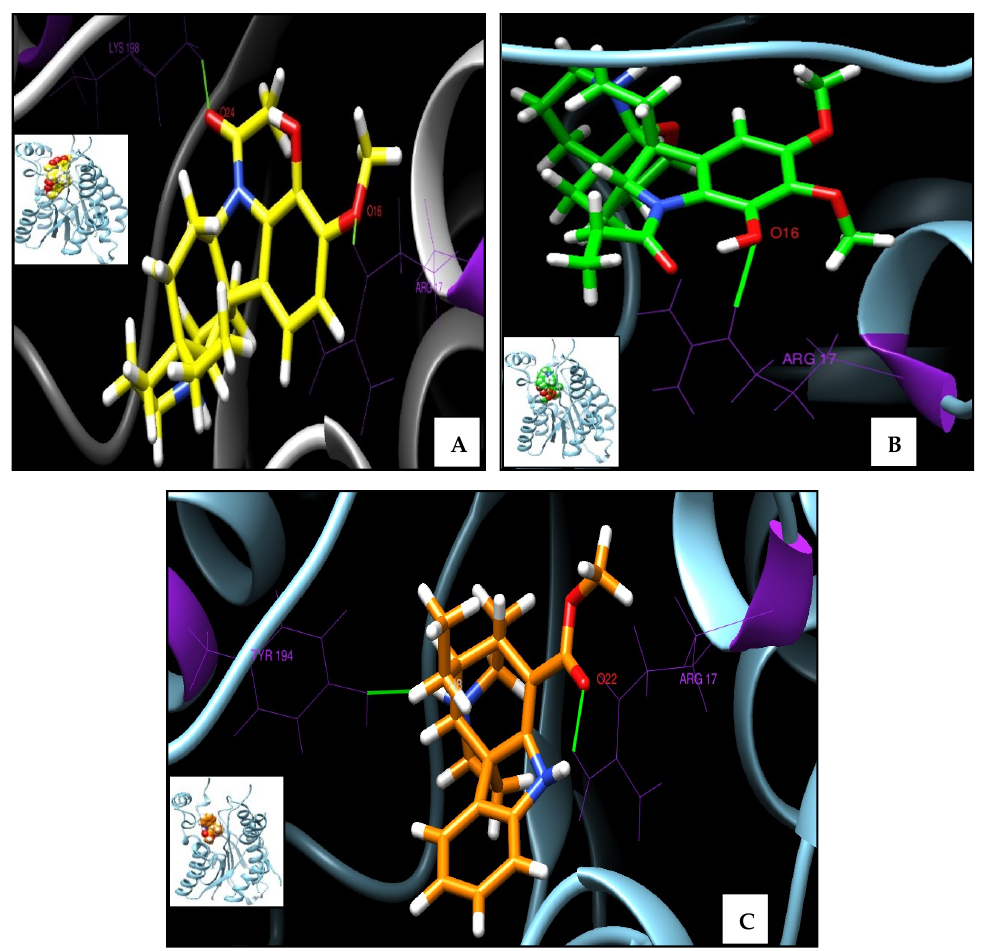
Figure A4. 3D molecular interactions of the complexes of PTR1 (PDB ID 1E7W) with ( A ) APC, ( B ) APA and ( C ) TBT. Small box, total vision, and big box, augmented vision, where the protein is represented in cartoon shapes (secondary structures) of sky blue, with H bonds in green and ligands in the form of colored sticks per element.